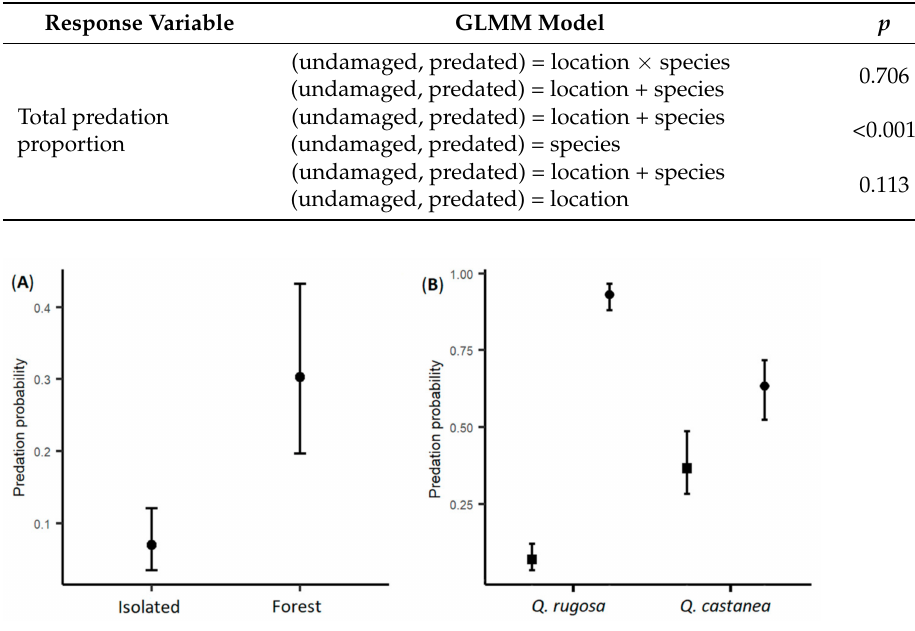
Figure 2. ( A ) Acorn predation probability of isolated trees and trees in the protected forest area Ecoguardas. ( B ) Acorn predation probability of Quercus rugosa and Q. castanea . Circles: predation by weevils, squares: predation by moths. Bars represent 95% confidence